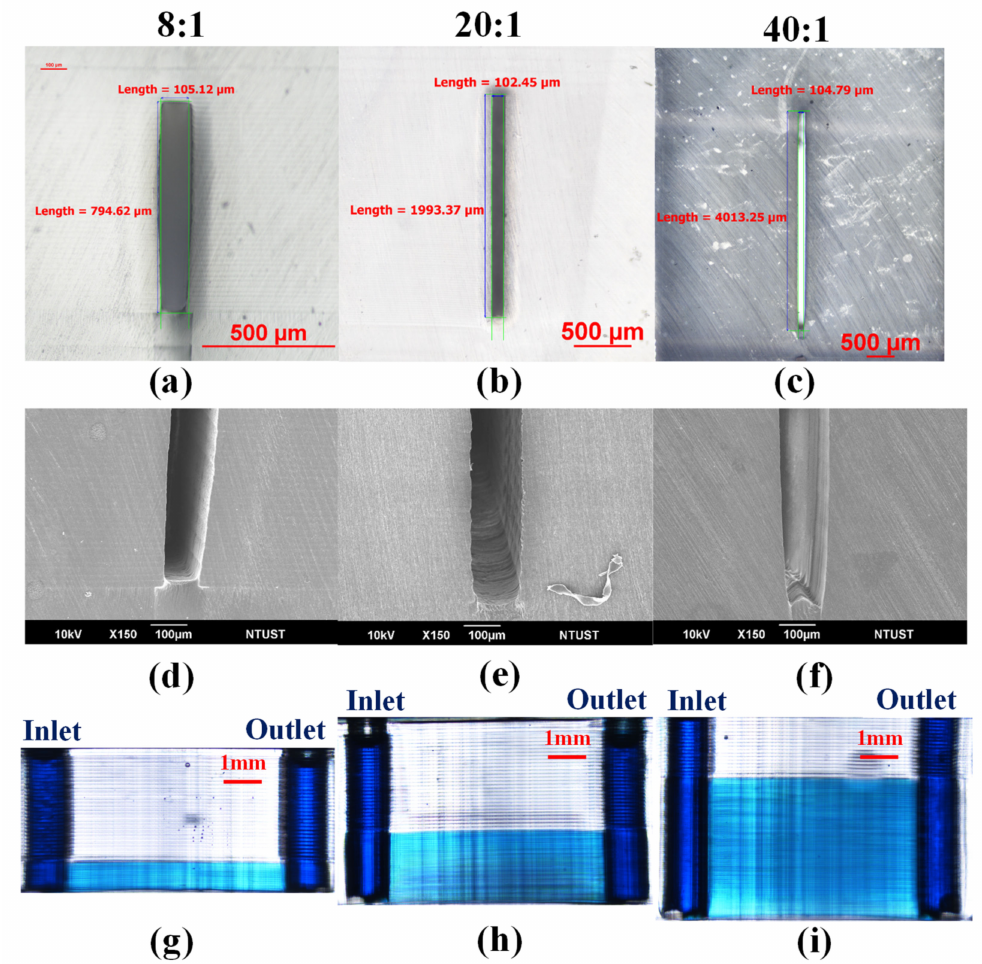
Figure 6. ( a – c ) Microchannels with cross-sectional areas of 795 µ m x 105 µ m (8:1), 1993 µ m × 102 µ m (20:1), and 4013 µ m × 105 µ m (40:1); ( d – f ) Partial SEM cross sections corresponding to aspect ratios of 8:1, 20:1, and 40:1; ( g – i ) side view of the microfluidic devices after injection of blue dye